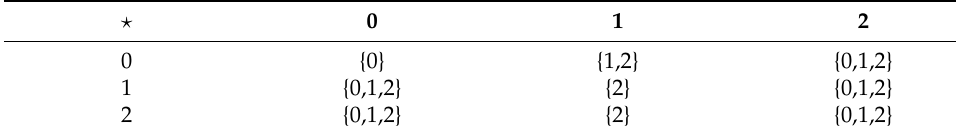
Table 18. The binary hypergroupoid ( C , (cid:63)